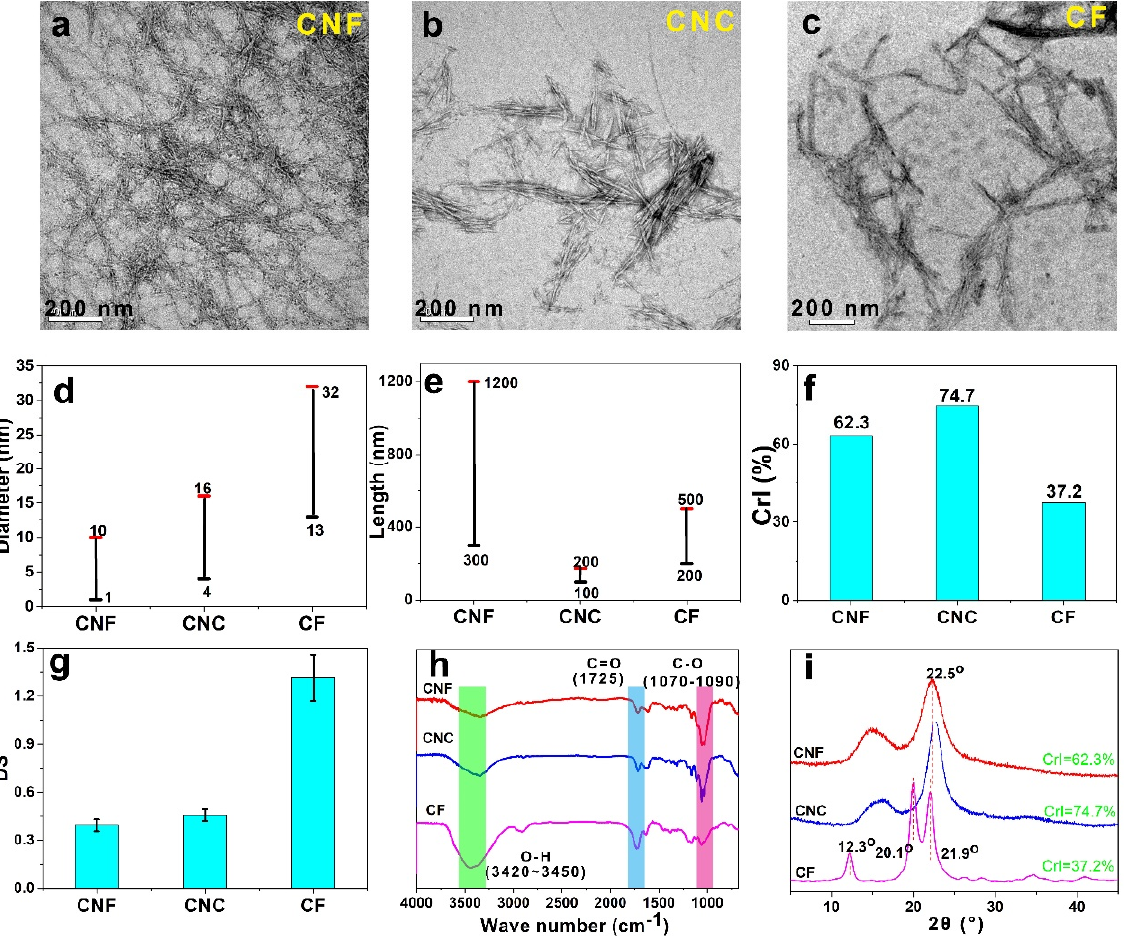
Figure 2. TEM images of CNF ( a ), CNC ( b ), and regenerated CF ( c ); Diameter ( d ), Length ( e ), CrI ( f ), DS ( g ), FTIR spectra ( h ), and XRD patterns ( i ) of CNF, CNC, and regenerated CF. Furthermore, the FTIR spectra and XRD patterns of NCF samples were recorded to analyze the structure characteristics. Figure 2h shows the FTIR spectra of NCF samples. Similar bands at 3420 cm − 1 to 3450 cm − 1 were assigned to O-H stretching vibrations